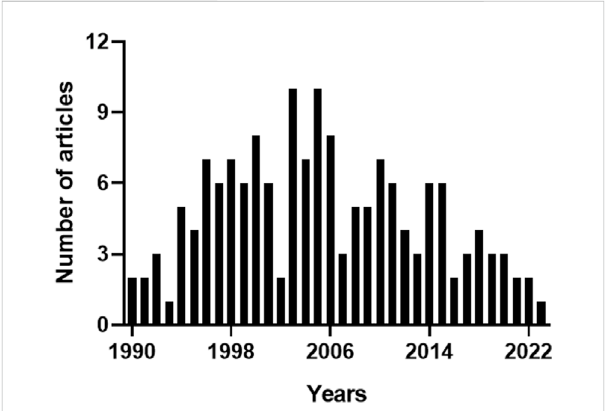
159 articles containing the keywords “ heme oxygenase-2 ” or “ haem oxygenase-2 ” in the title, and matching both Pubmed and Scopus archives, were sorted by publication year. 2003 and 2005 were the years with the highest number of articles published. For further information, see